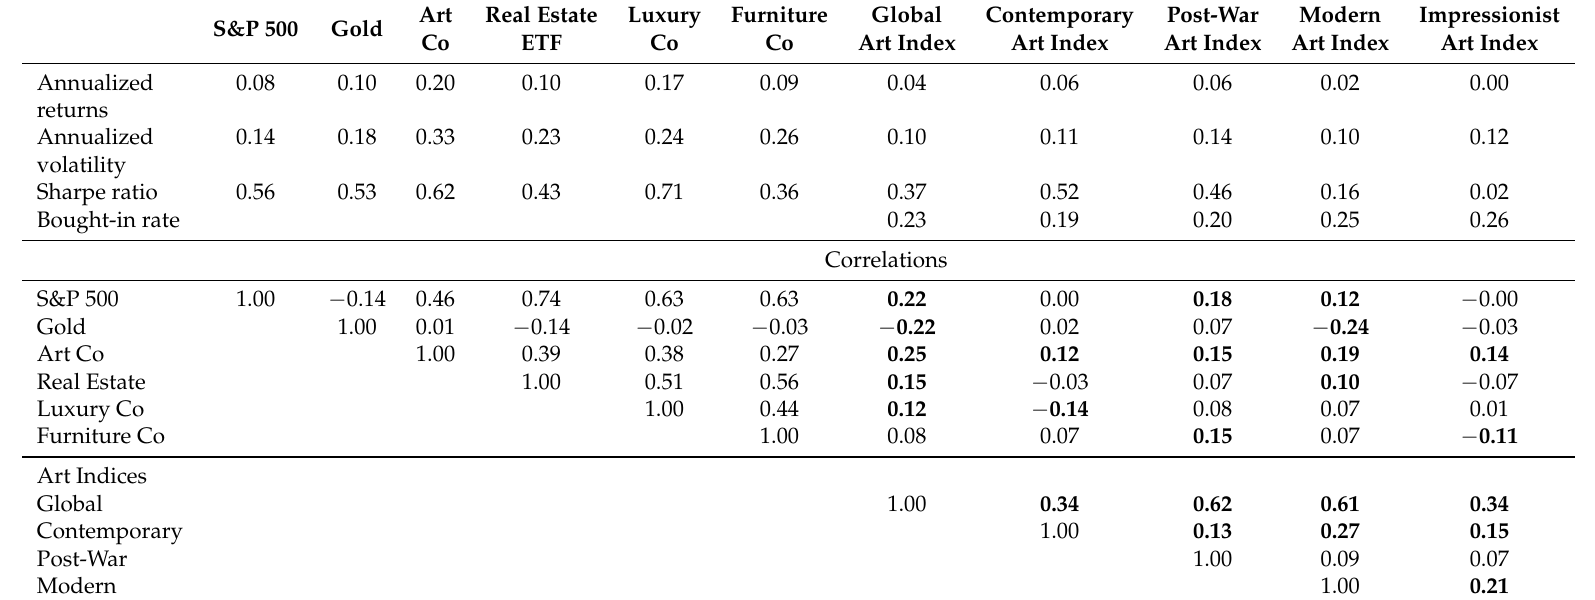
Table 1. Returns, volatility, and correlation of the price